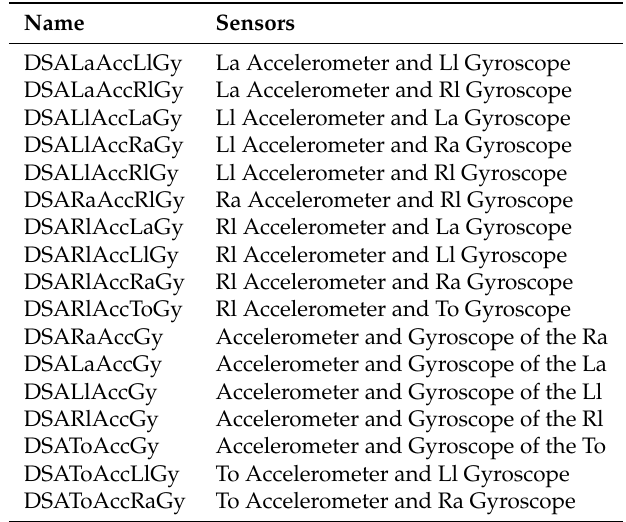
Table 4. Data sets obtained from the data of the IMUs of the DSA data